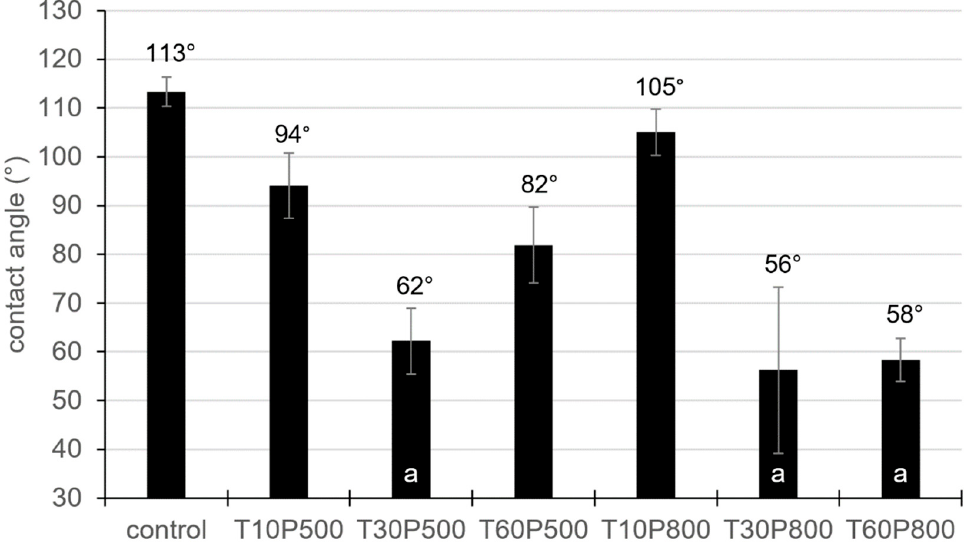
Figure 3. Effect of LPMD treatment on water contact angle on the surface of the pea seeds (the letter signs the variants that are not significantly different; vertical lines denote standard deviation bars).